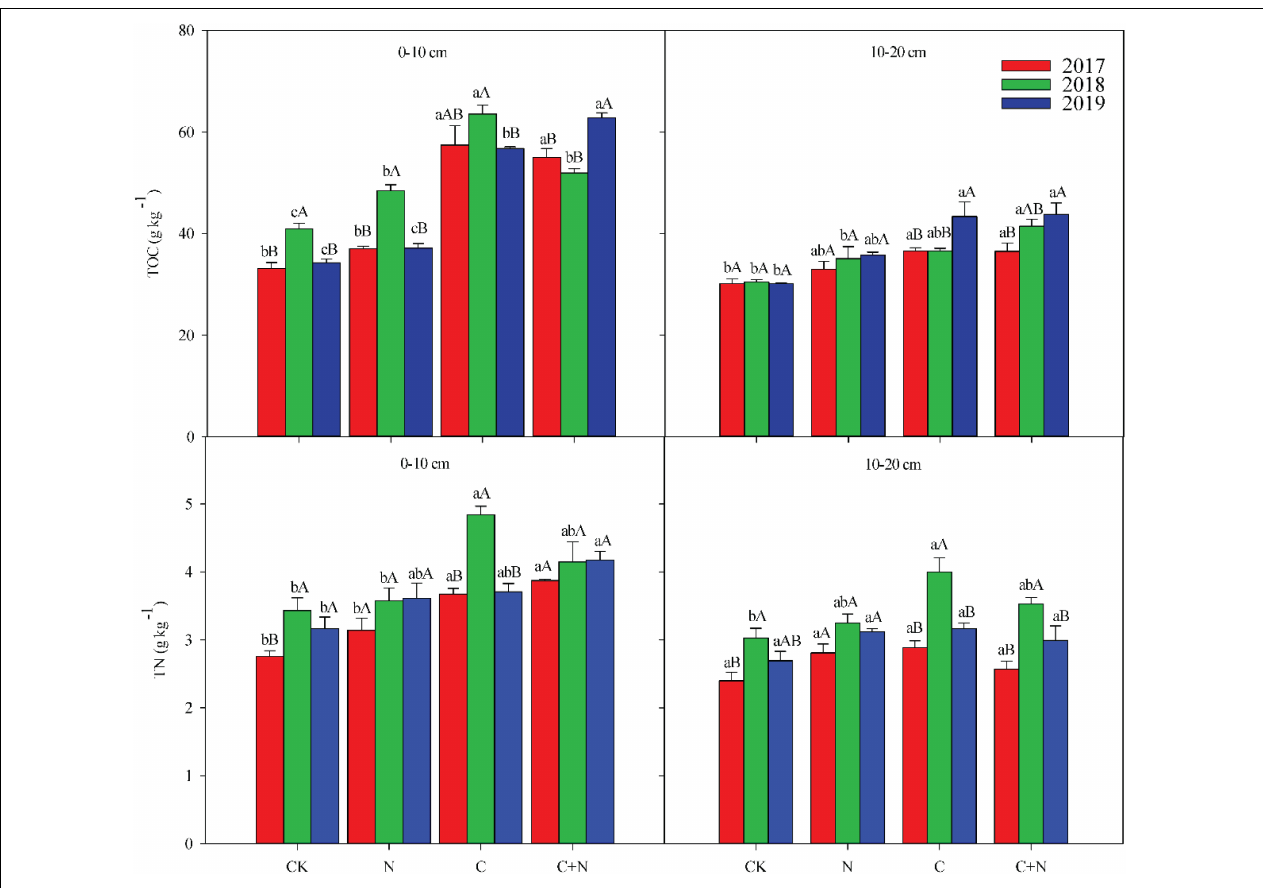
FIGURE 1 | Effects of different treatments on soil total organic carbon (TOC) and soil total nitrogen (TN) in 0–20 cm soil layers in 2017, 2018, and 2019. Error bars represent standard errors of the mean values, and different lowercase letters over the bars indicate differences among different treatments in the same year at P < 0.05. Different uppercase letters over the bars indicate differences among different years in the same treatment at P <